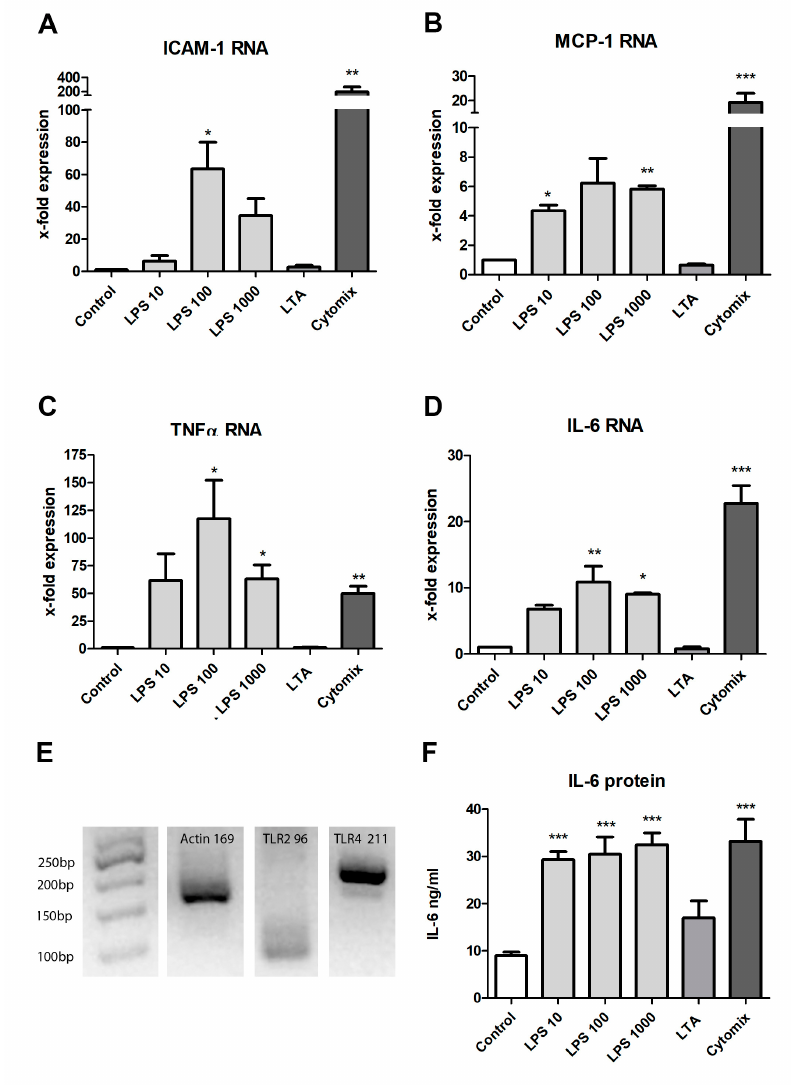
Figure 4. Effect of lipopolysaccharide (LPS) (10, 100, 1000 ng/mL), LTA (1000 ng/mL) or a cytokine mix (cytomix). ( A – D ) Assessment at the mRNA level by qPCR for ICAM-1, MCP-1, IL-6, and TNF α